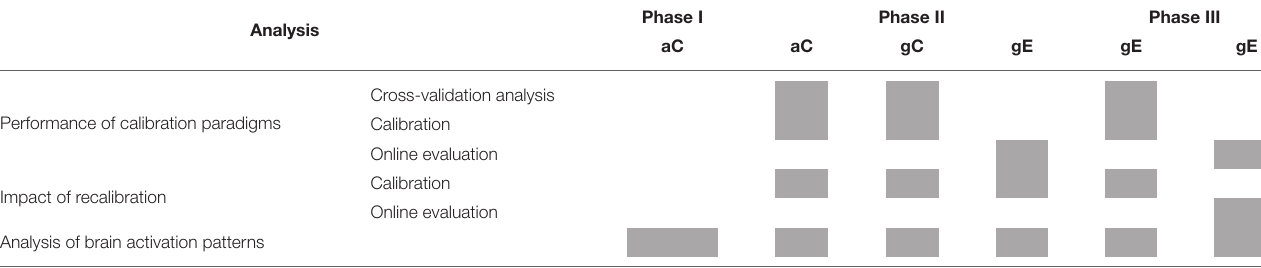
TABLE 1 | Summary of the usage of data for classification and data